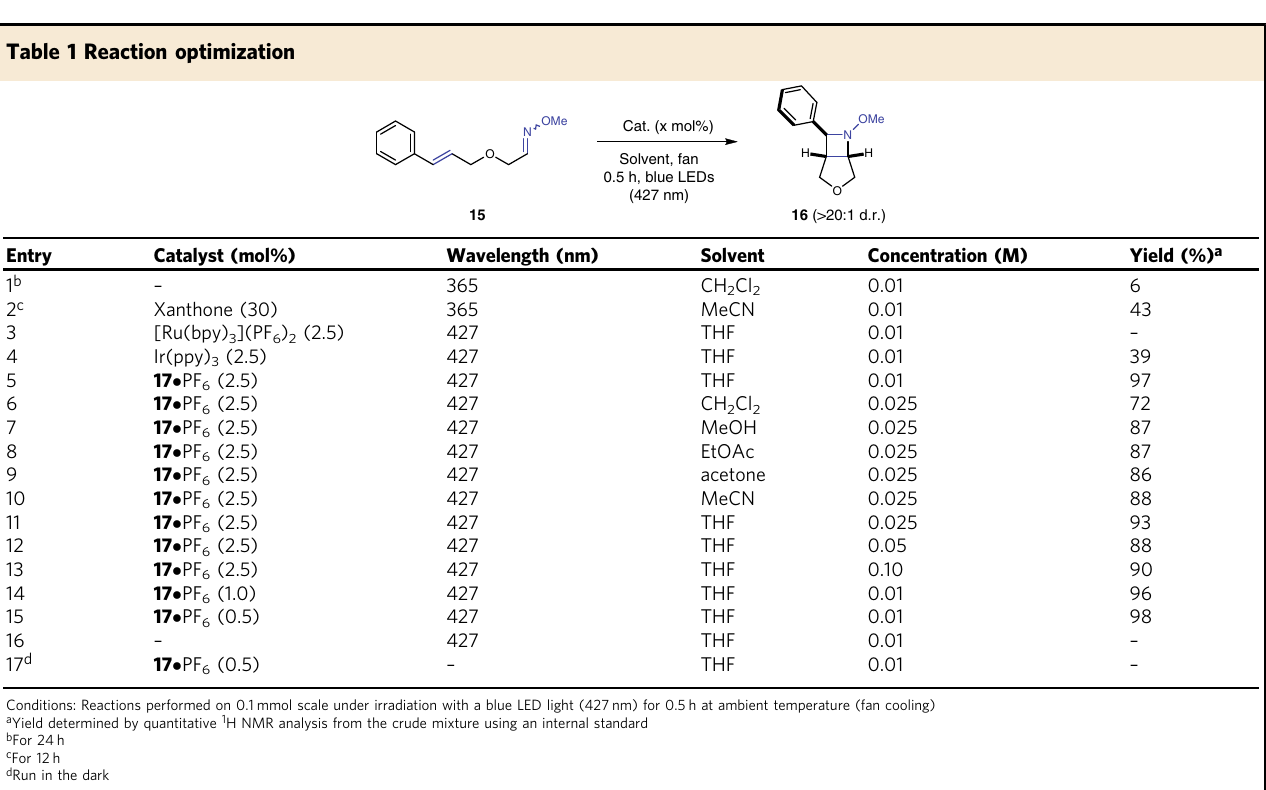
Table 1 Reaction optimization